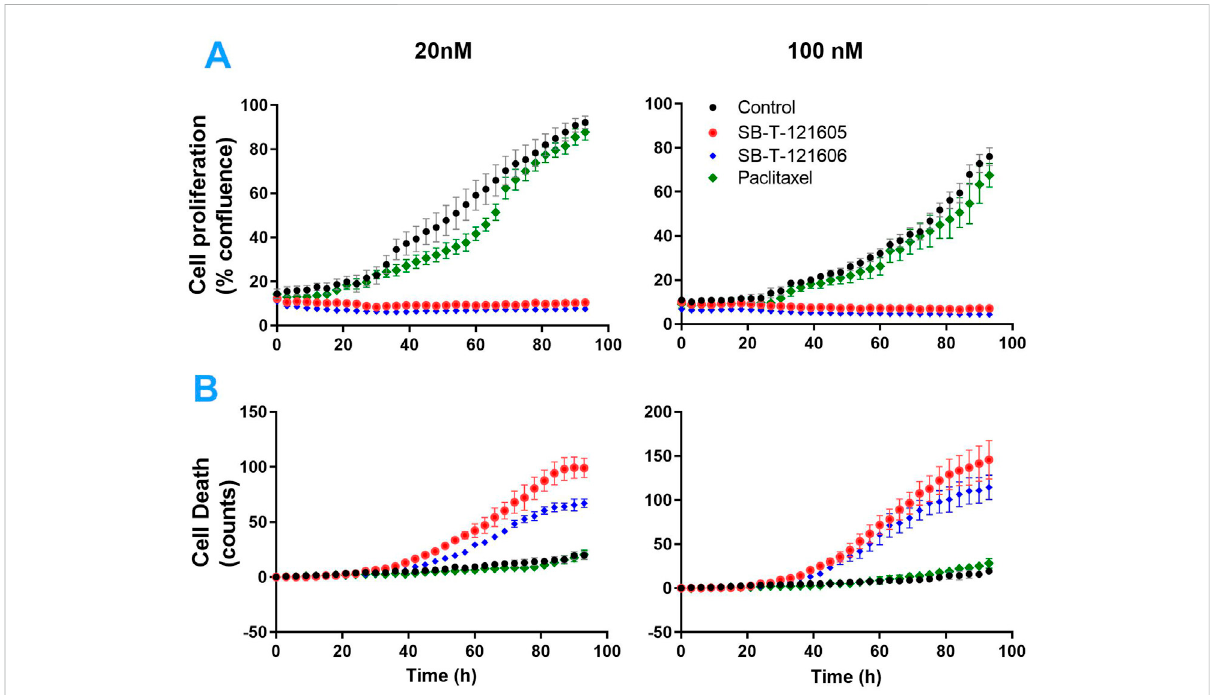
FIGURE 3 Proliferation (A) anddeath (B) ofNCI/ADR-REScellsmeasuredbythereal-timemonitoringfor96